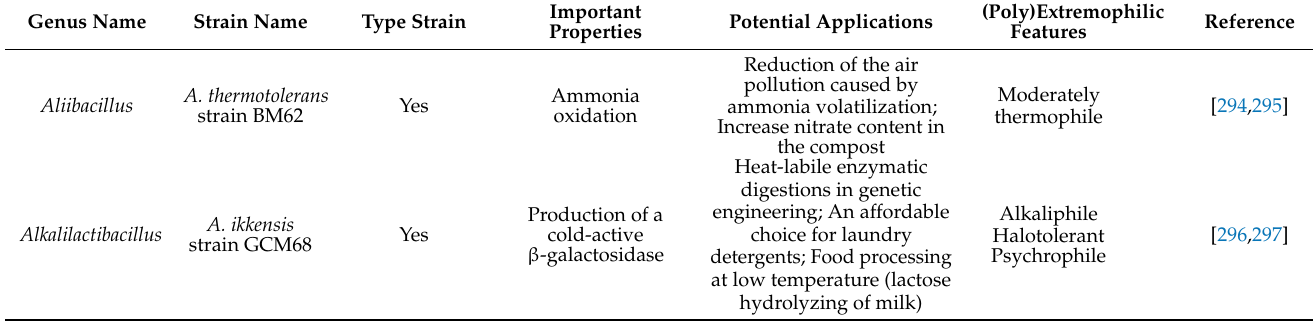
Table 3. Industrial and biotechnological potential of some (poly)extremophilic genera in the order Bacillales